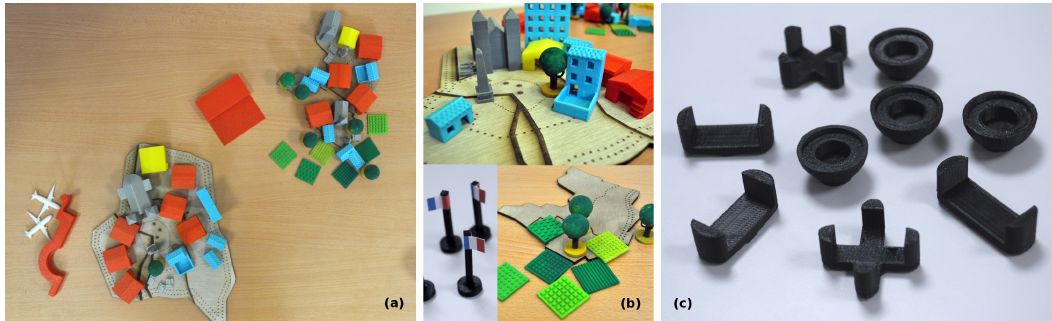
Figure 4. ( a ) all tangibles designed for the study; ( b ) examples of tangibles: various buildings, flags and green spaces; ( c ) conductive bowls (top right), and conductive supports for the other